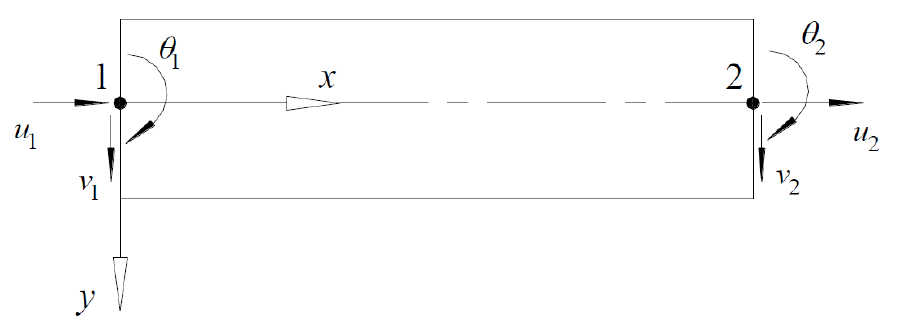
Figure 1. Beam element, u , v , and θ are the axial, transverse displacements, and rotation,